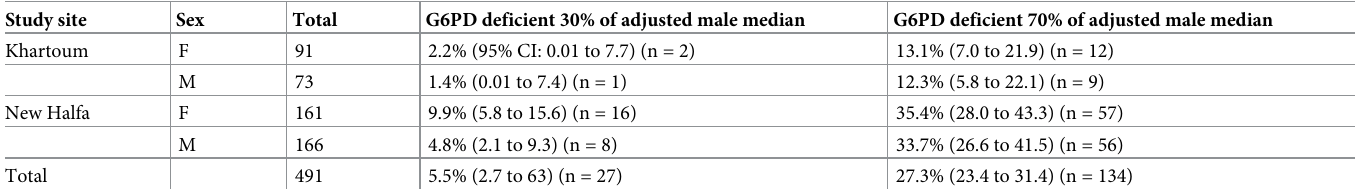
Table 3. Prevalence of G6PD deficiency in surveyed populations by biochemical testing (SPINEACT test) (adjusted male median = 4.23 U/g Hb), New Halfa and Khartoum Sudan, 2015. Study site